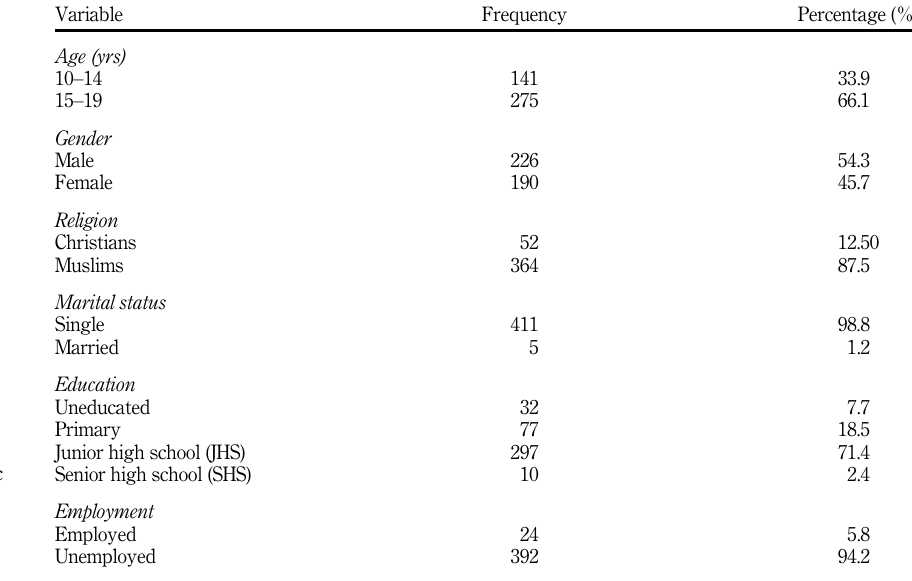
Table 1. Sociodemographic characteristics of adolescents